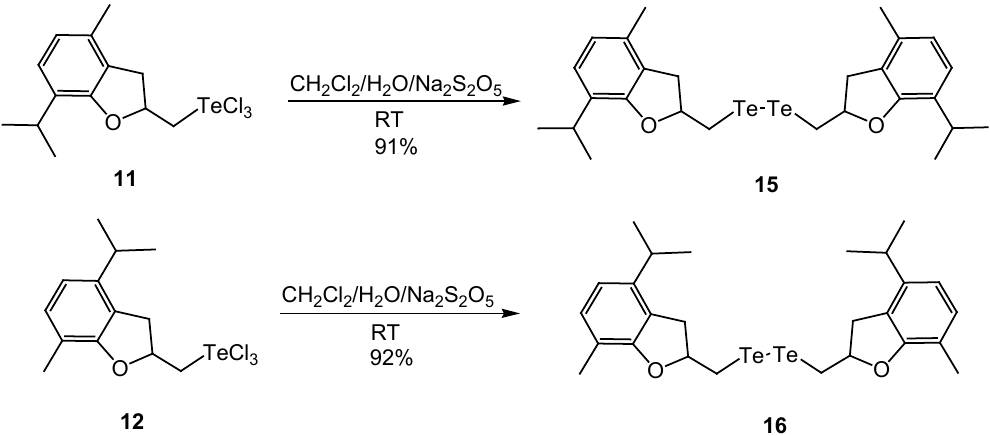
Scheme 8. Synthesis of ditellurides 15 and 16 by the reduction of trichlorotellanes 11 and 12 with sodium metabisulfite.